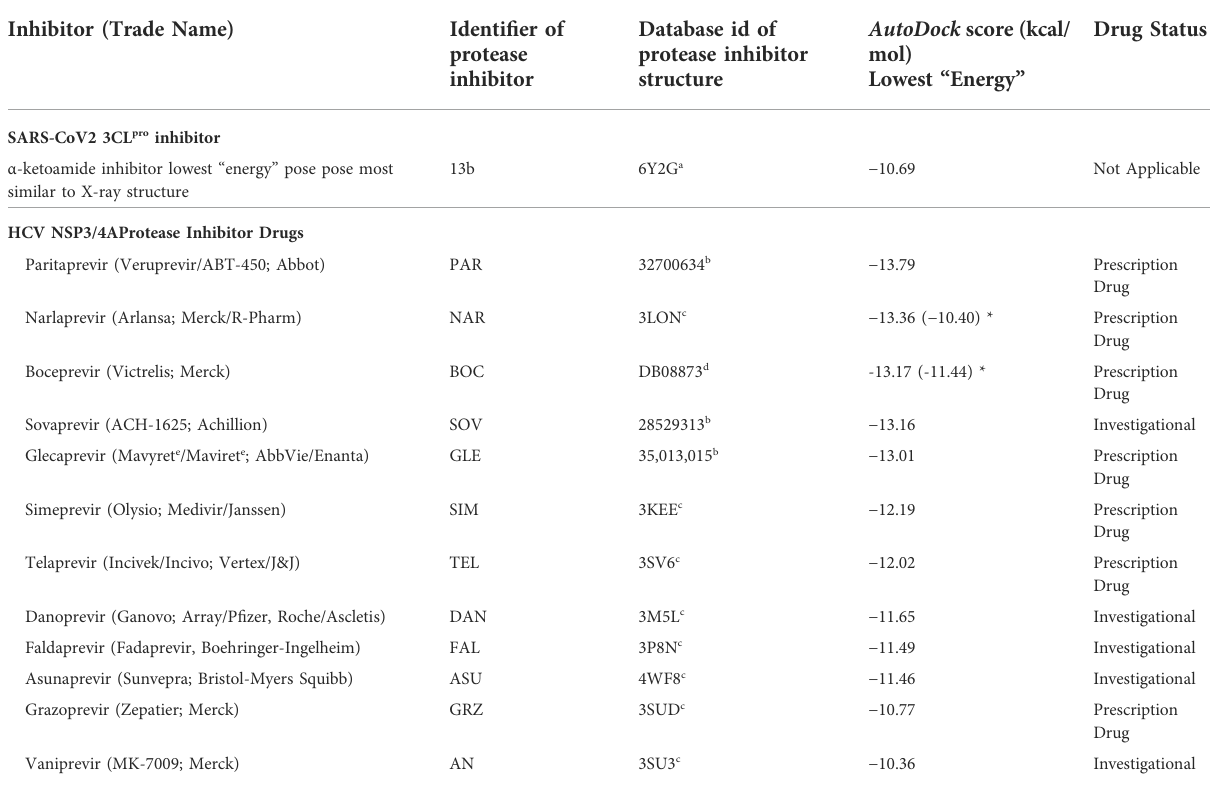
TABLE 2 Docking scores for HCV 3C/4A protease inhibitors with SARS-CoV2 3CL pr . o